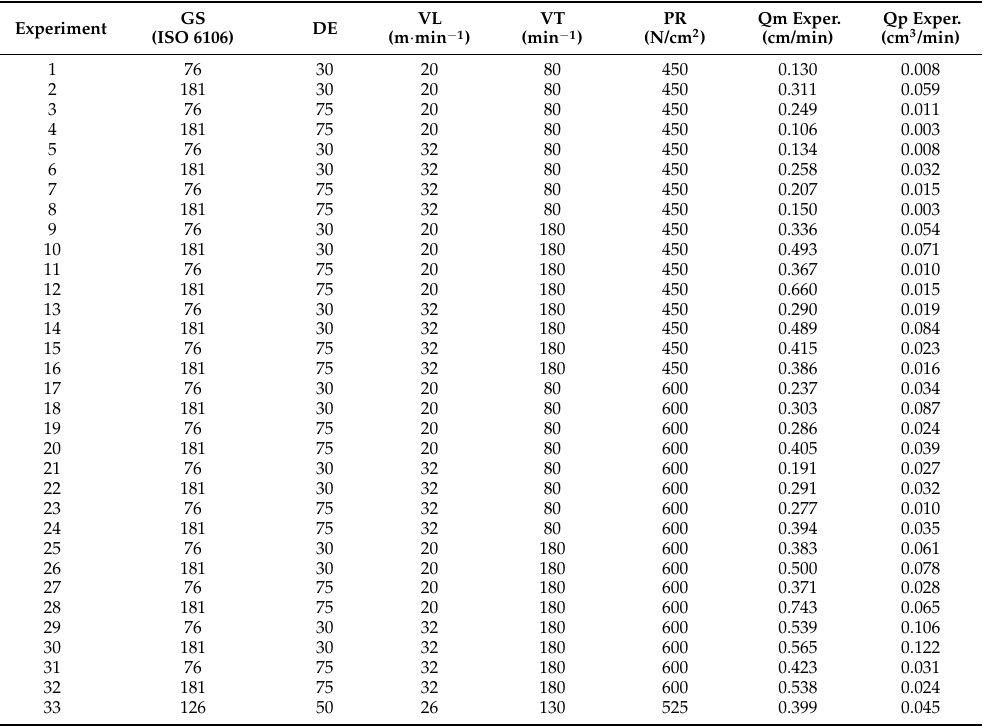
Figure 6 corresponds to the main effects plot for Qm.